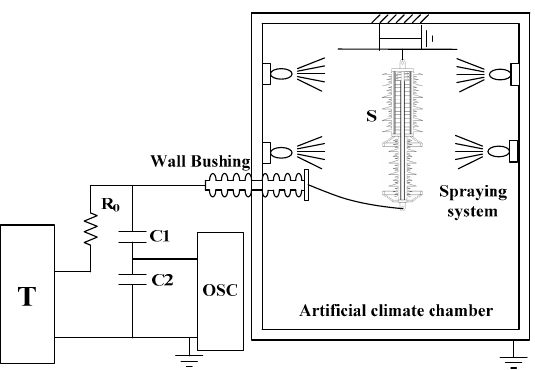
Figure 1. Experimental circuit. T is the power supply, R 0 is the 5 k Ω protective resistor, C 1 and C 2 are the voltage divider, OSC is the oscilloscope and S is the test specimen.